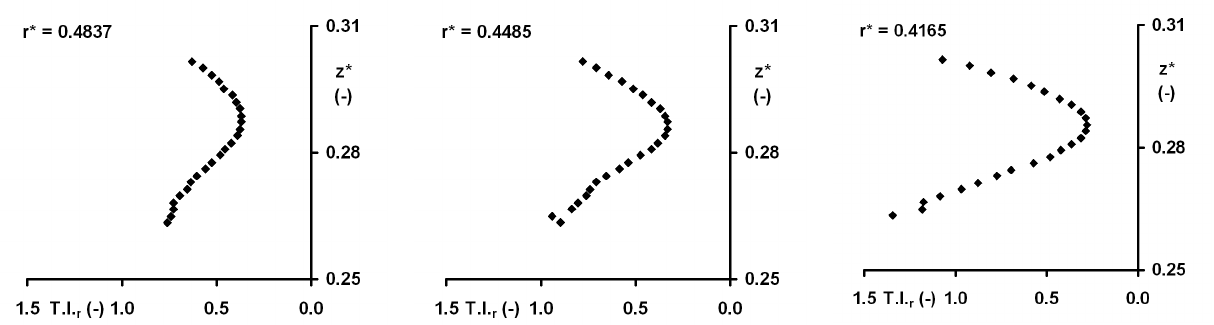
Fig. 10. Radial turbulence intensity profiles T.I. r = f ( z * ) in the impeller discharge